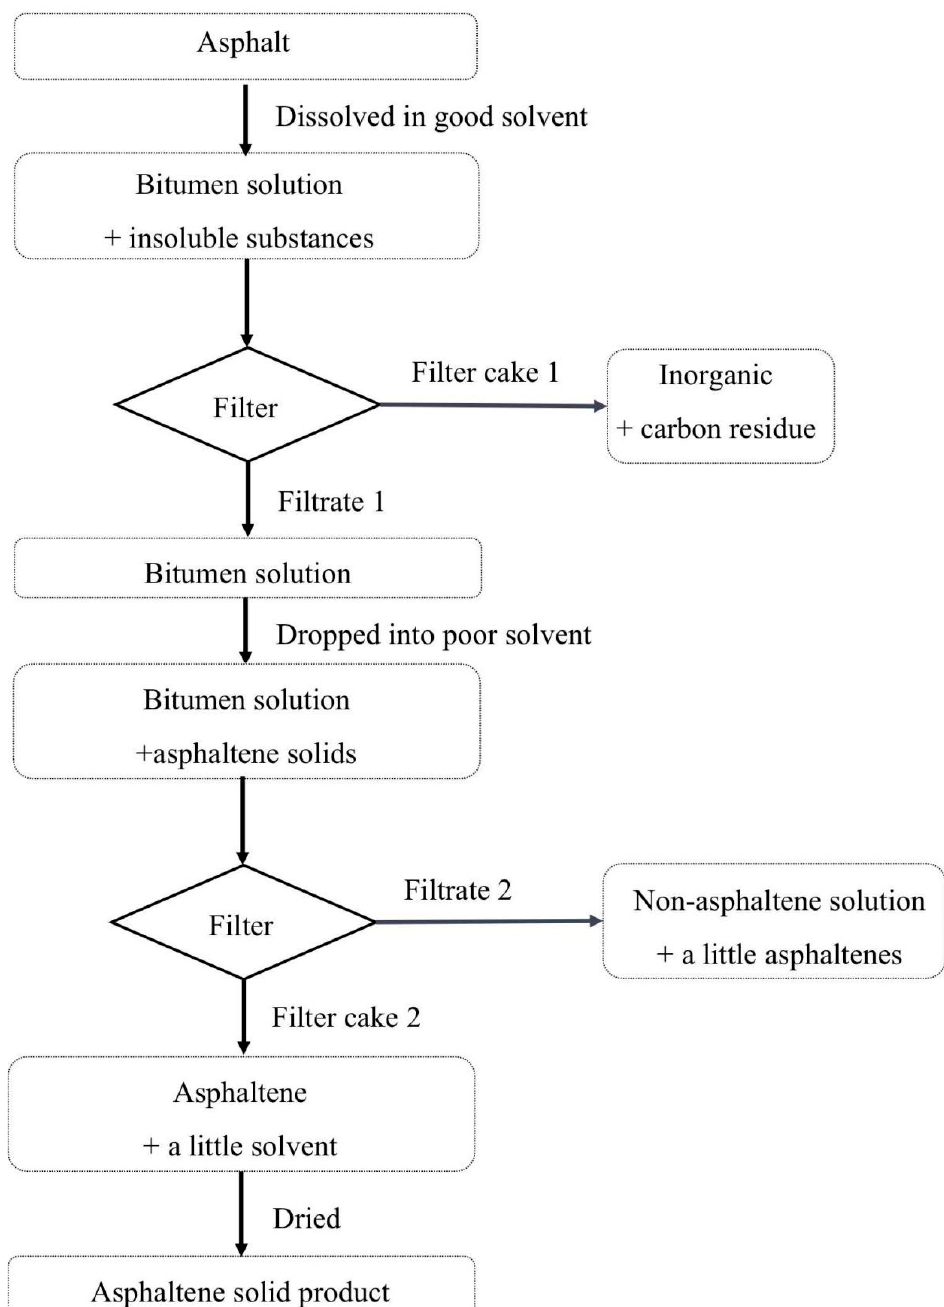
Figure 1. Flowchart for extraction of asphaltenes from bitumen at room temperature.